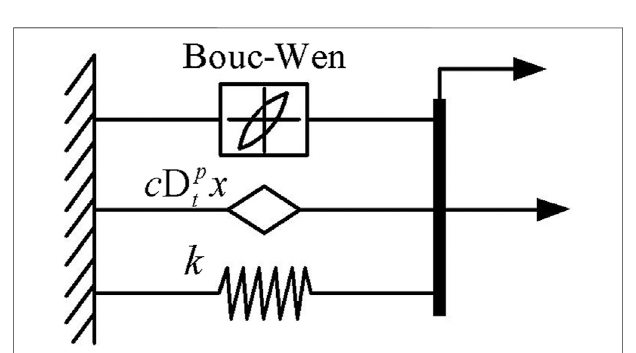
FIGURE 3 | Modi fi ed Bouc-Wen